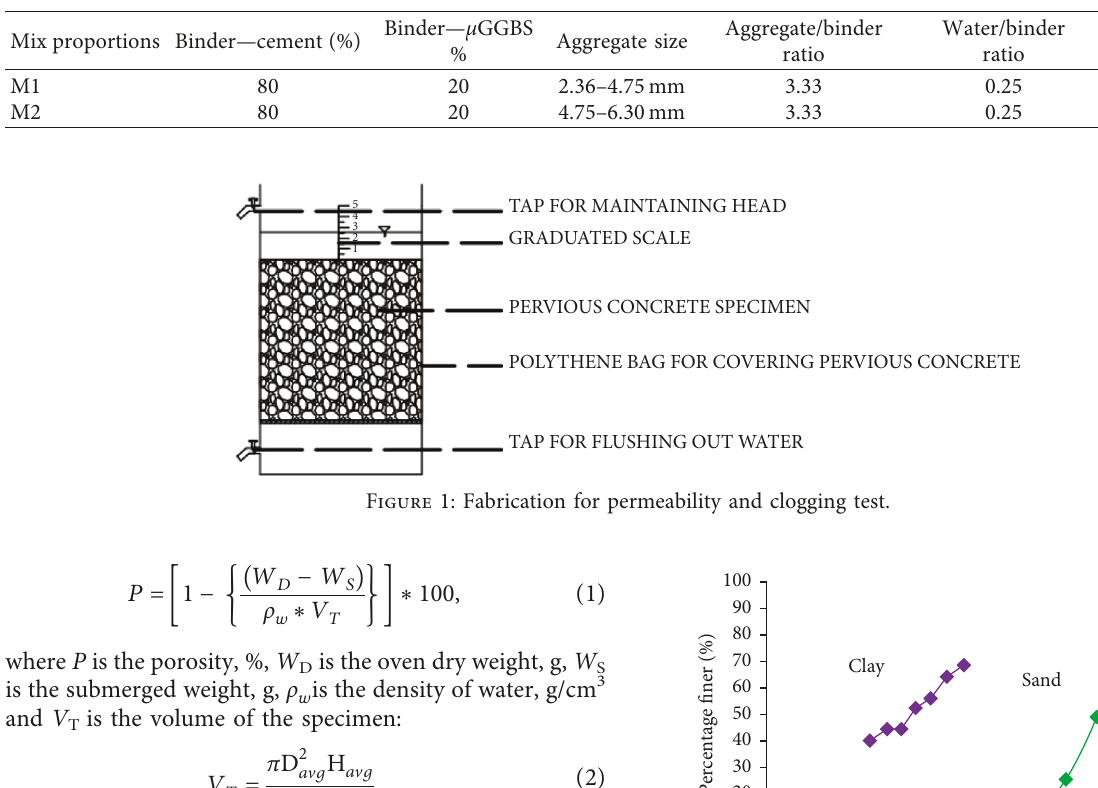
Table 2: Mix design of the pervious concrete mixes.